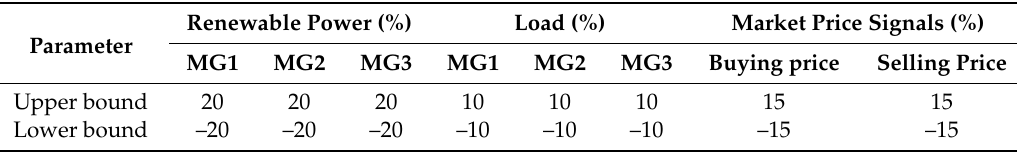
Table 3. Uncertainty bounds for uncertain parameters in each